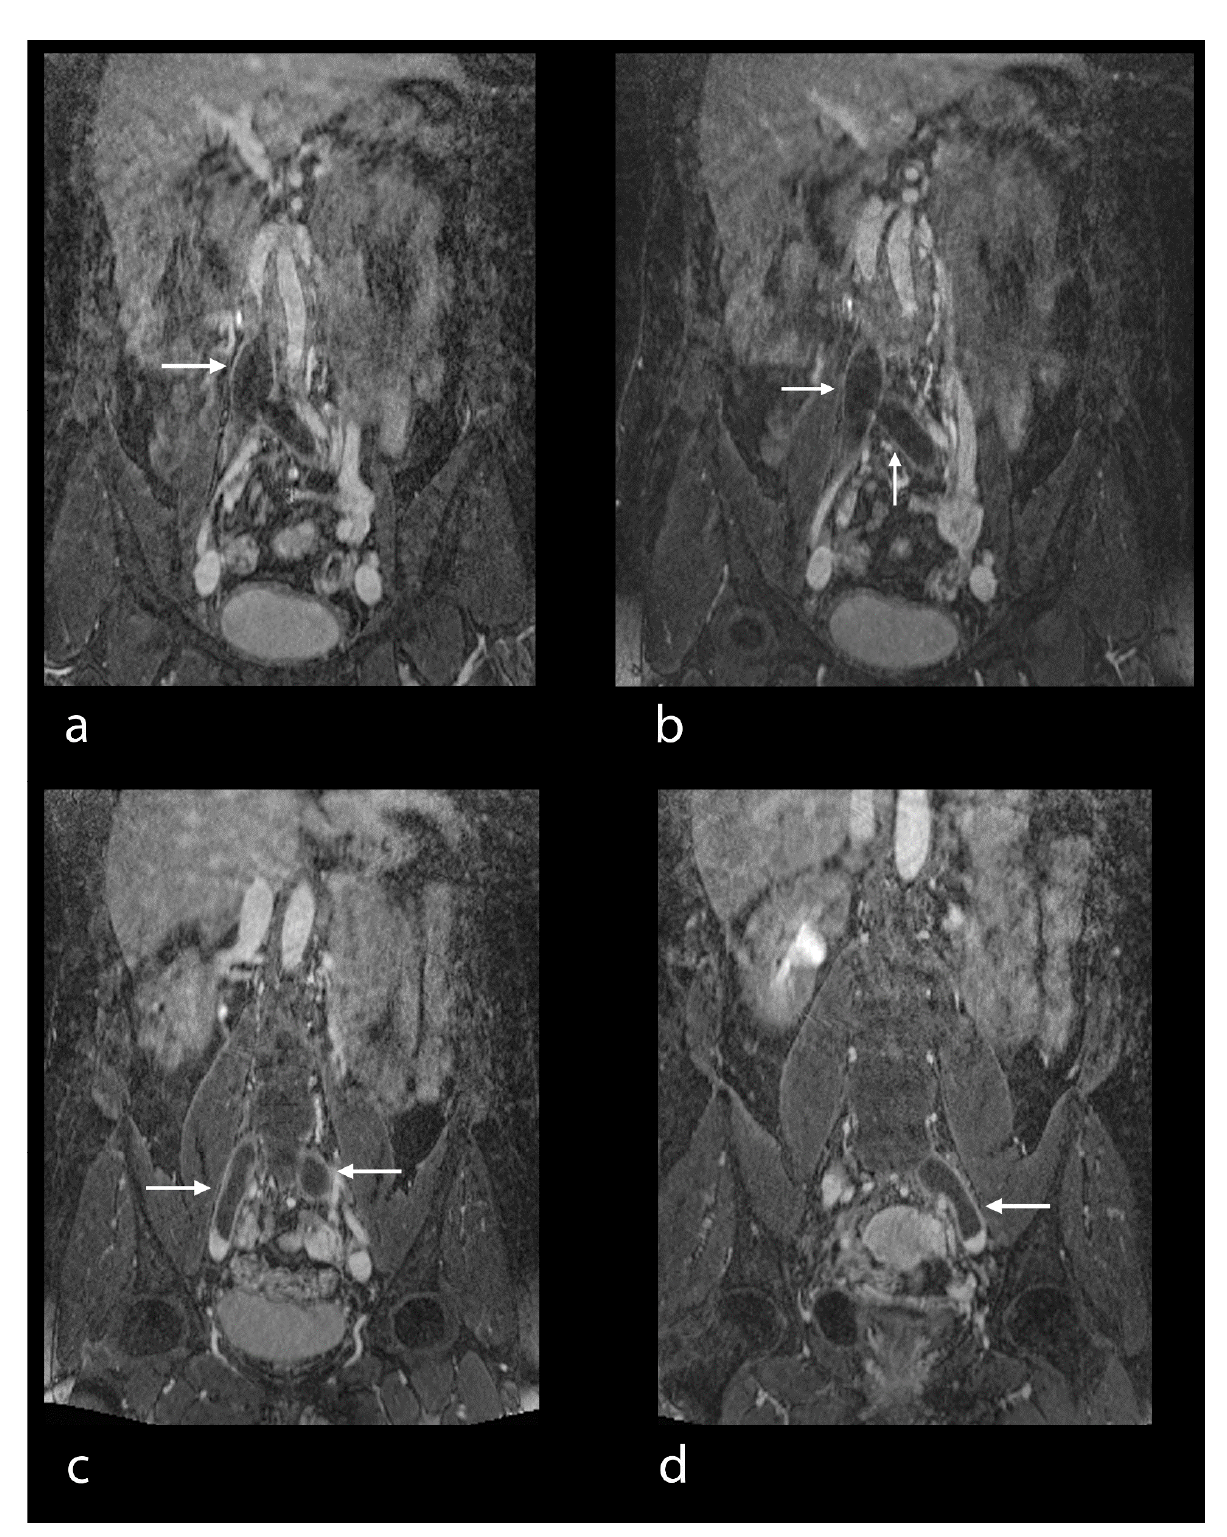
Figure 4. ( a – d ) MRV in a 47-year-old female patient. Thrombus in the inferior caval vein, the common iliac veins and the left external iliac vein (see arrows). Good examination quality.